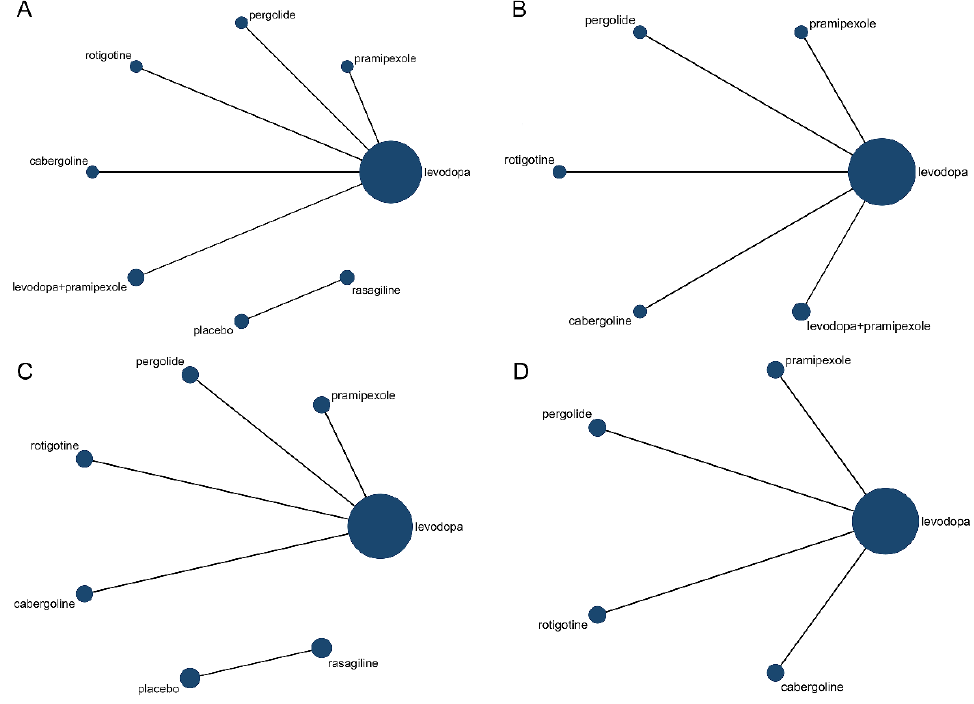
Figure 2. Evidence network diagram of this network meta-analysis. ( A ) Evidence network diagram of letter fluency with rasagiline; ( B ) evidence network diagram of letter fluency without rasagiline; ( C ) evidence network diagram of semantic fluency with rasagiline; ( D ) evidence network diagram of semantic fluency without rasagiline. Because rasagiline did not present connection with other drug regimens, it was excluded from this NMA. Each spot indicates a drug regimen, the size of spot indicates the total number of participants, and each line indicates a comparison between the connected drug regimens.